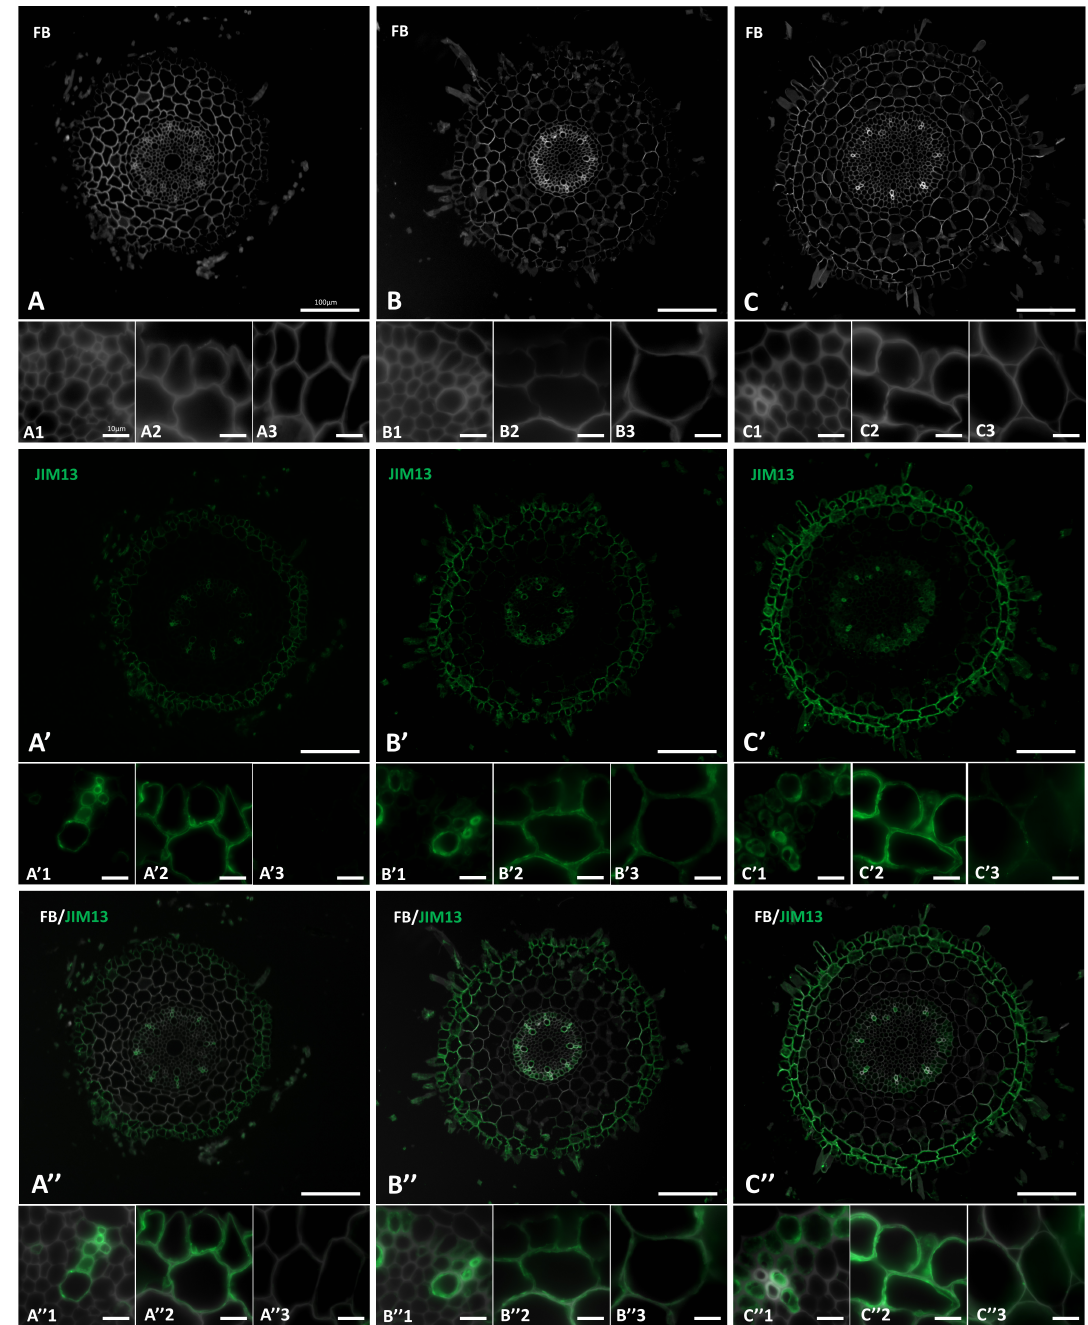
Figure 5. Immunolocalization of the JIM13 epitope in cross-sections of the “salt stressed” Brachypodium roots. ( A, A′ , A″ ) control, ( B, B′ , B″ ) 100 mM NaCl, ( C, C′ , C″ ) 200 mM NaCl. Fragments of vascular cylinder are marked by the numeral 1, rhizodermis and exodermis by the numeral 2, and cortex cells by the numeral 3. FB—fluorescent brightener. The green colour shows epitope occurrence. Scale bars for A, A′ , A″ , B, B′ , B″ , C, C′ , C″ represent 100 µm and for all other photomicrographs: 10 µm.